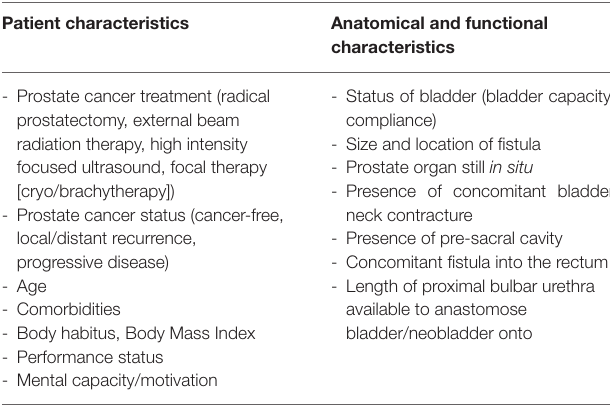
TABLE 2 | Important patient and anatomical characteristics determining reconstructive surgery vs. cystectomy including urinary diversion in patients with devasted bladder outlets after prostate cancer